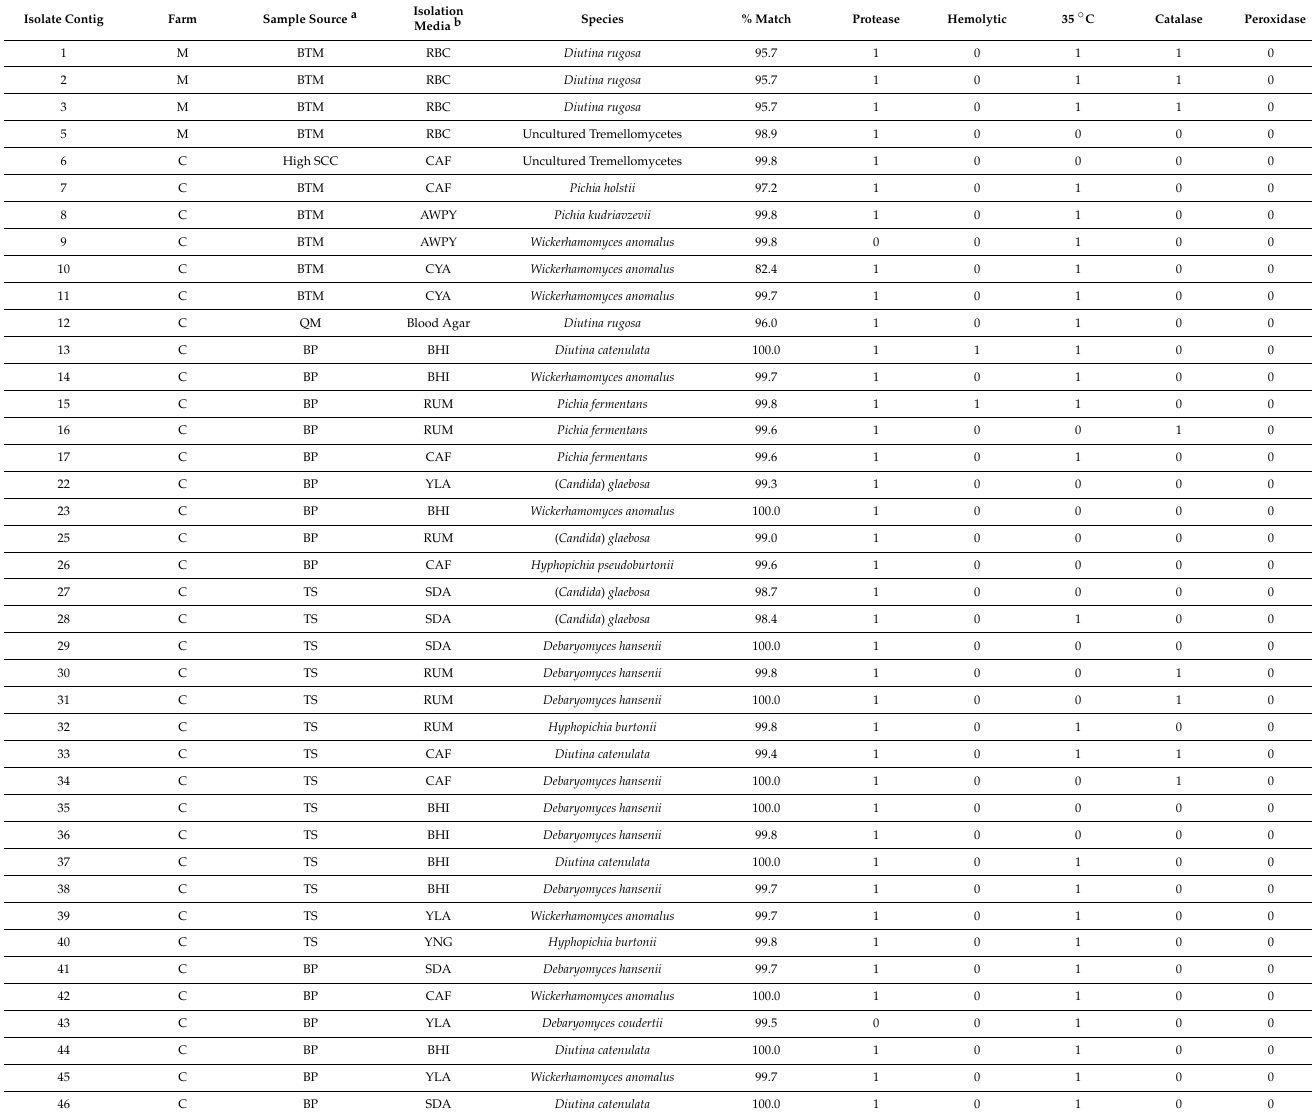
Table 3. Sanger Sequencing results for cultured yeast isolates and their respective physiological characteristics. Samples collected in December 2019, January 2020, and February 2020 at Farms M (milk only) and C (milk and bedding). Species were identified by Sanger sequencing of the amplicon generated by NS7-F and ITS2-R primers and contigs assembled using CAP3 [27]. Nucleotide sequences were blasted in NCBI, all yielding E values of 0. Percentage nucleotide matching for the assembled contig sequence is